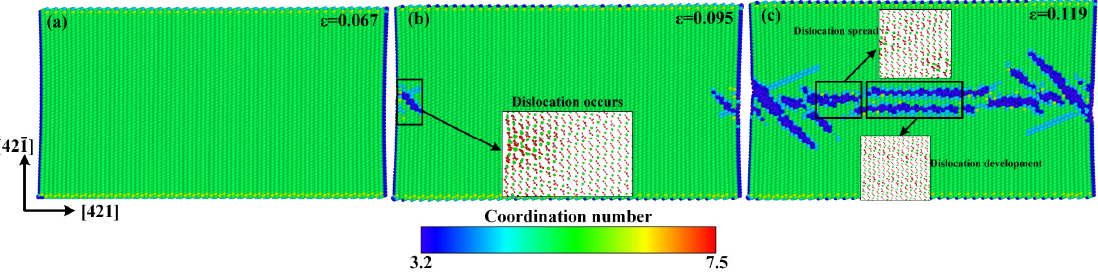
Figure 10. Atomic configurations when the tensile strain along the [ 421 ] direction reaches: ( a ) ε = 0.067, ( b ) ε = 0.095, and ( c ) ε = 0.119.